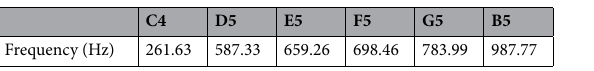
Table 1. Frequency of each